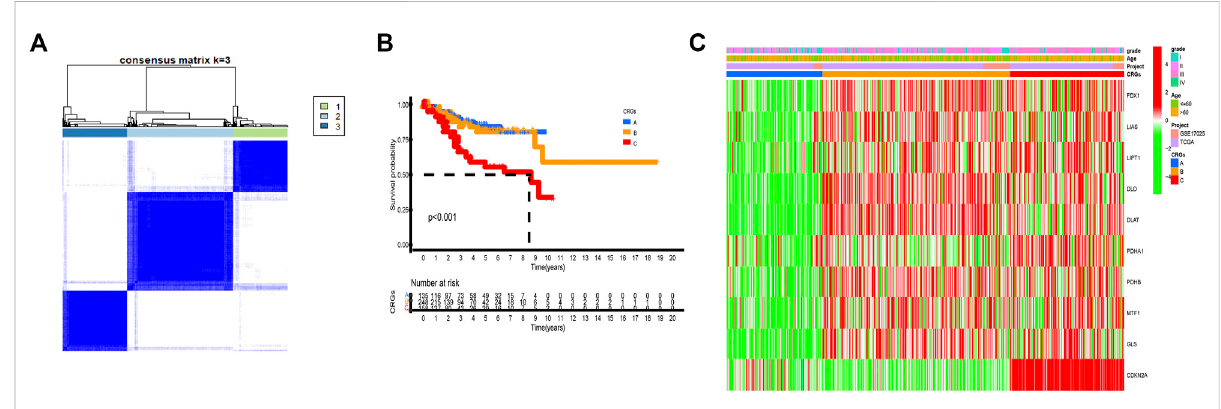
FIGURE 3 Three cuproptosis patterns and their clinical features. (A) Consensus clustering matrix of 10 CRGs for k = 3 using unsupervised clustering analysis. (B) Kaplan – Meier survival analysis of three cuproptosis patterns in the UCEC. p -value < 0.05 is considered a statistical difference among three cuproptosis patterns. (C) The heatmap presented the expression of 10 CRGs among three different cuproptosis patterns by unsupervised clustering in TCGA-UCEC and GSE17025 UCEC patients. The relationship among the CRGs cluster, grade, and age of 10 CRGs were used as notes. Red represented high expression and green represented low